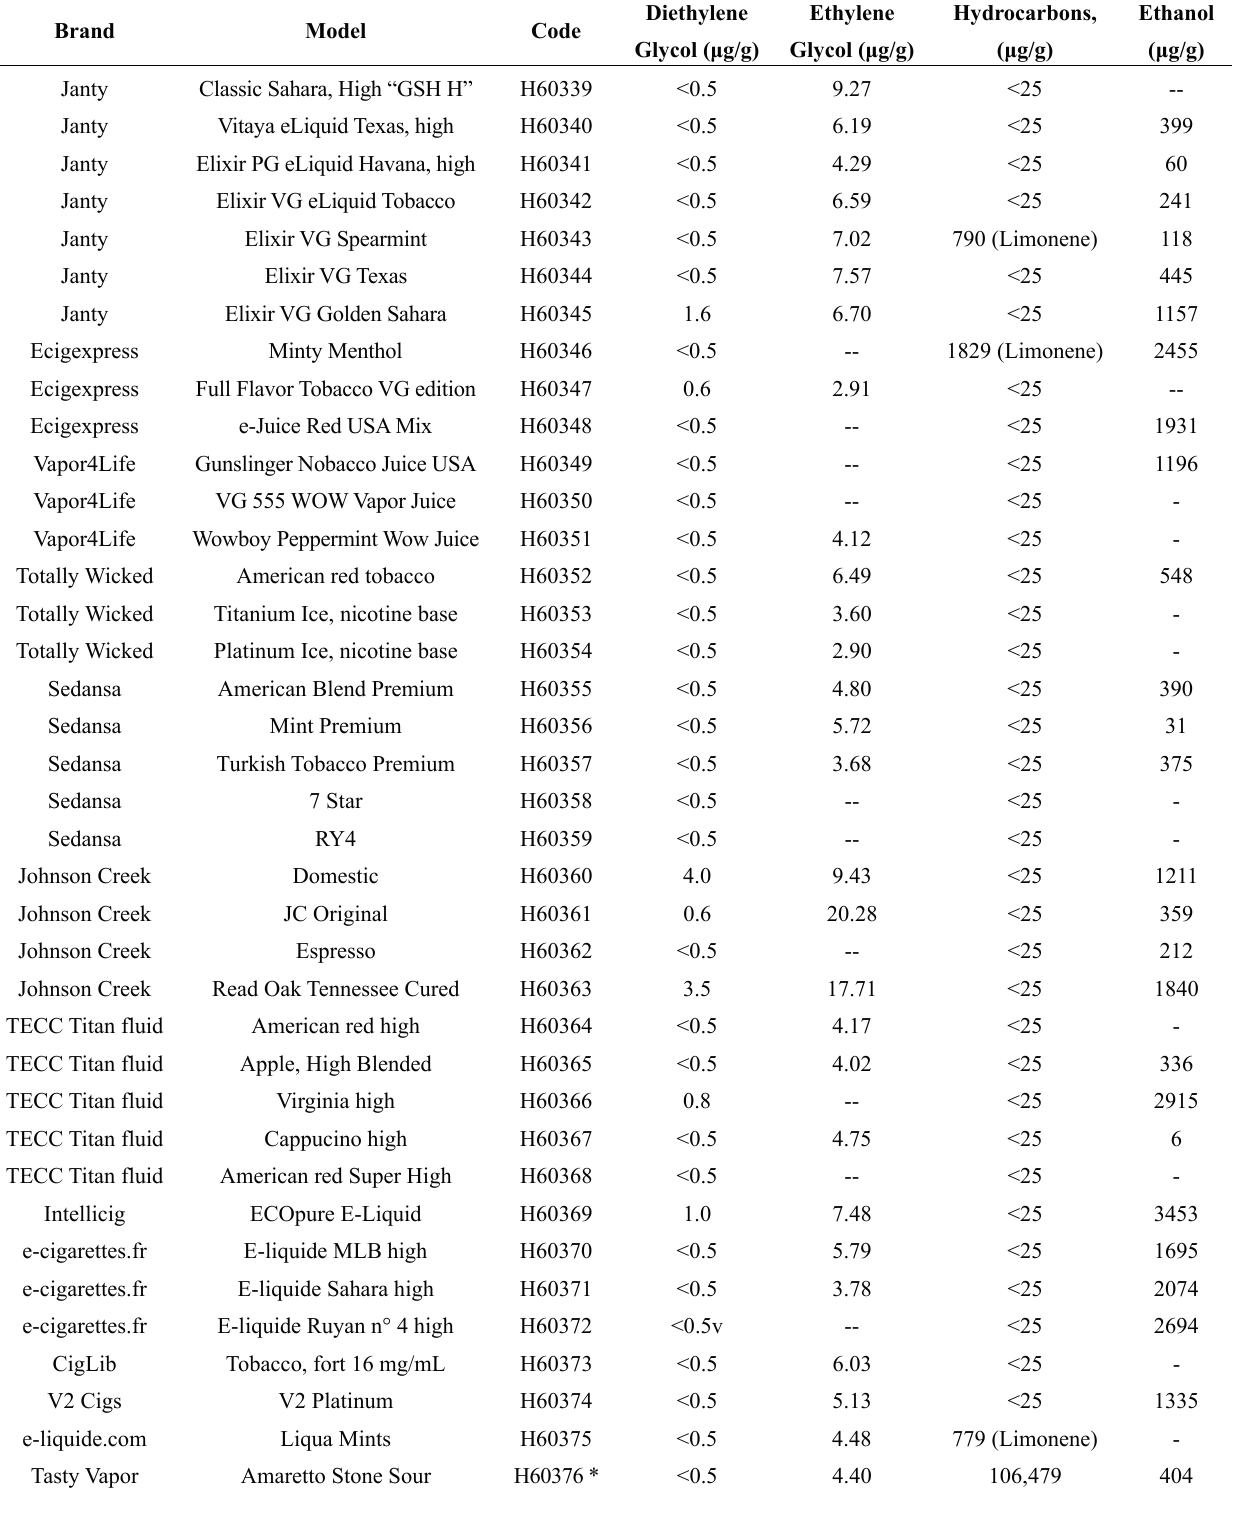
Table 2. Content of 42 bottles of liquids for e-cigarettes,